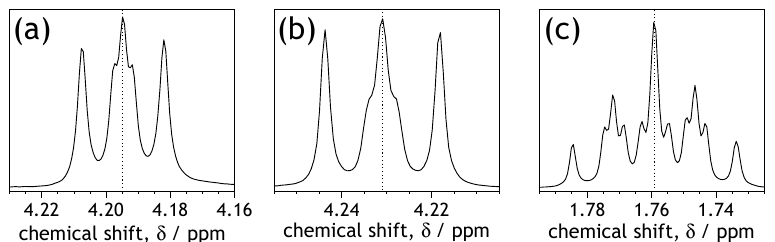
Figure 4. Examples of 1 H NMR signal profiles of: ( a ) NCH 2 protons of NDIC3 with clearly indicated five lines of multiplet; ( b ) NCH 2 protons of NDIC4 with broadening of a middle line of multiplet (note the shift at the δ -scale); and ( c ) β –methylene group protons (NCH 2 CH 2 CH 2 ) of NDIC4.